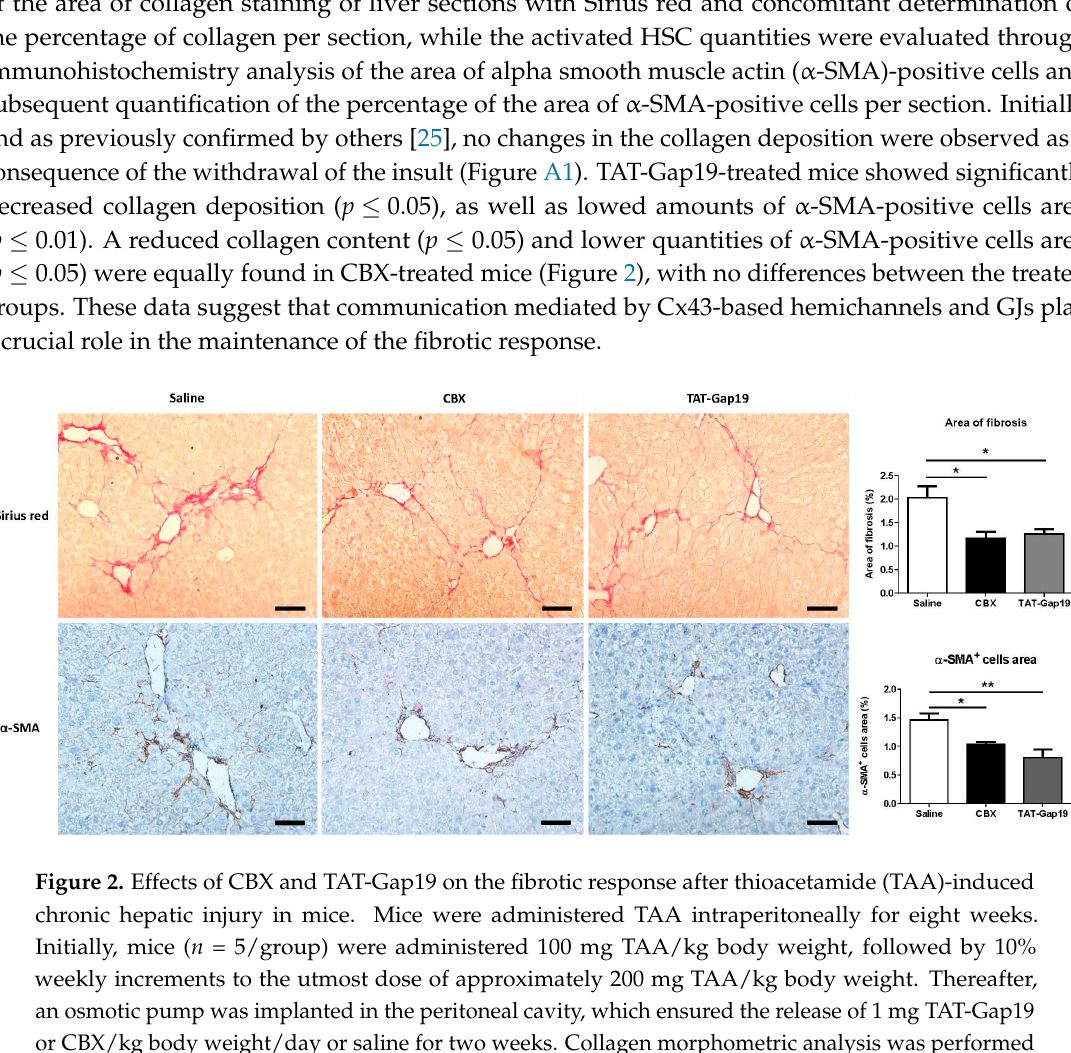
TAT-Gap19 did not affect serum levels of the necrotic cell death markers alanine aminotransferase (ALT) and aspartate aminotransferase (AST). Surprisingly, CBX increased AST quantities ( p ≤ 0.05). Neither TAT-Gap19 nor CBX influenced serum levels of albumin and conjugated and total bilirubin, which is indicative of hepatocyte functionality (Figure